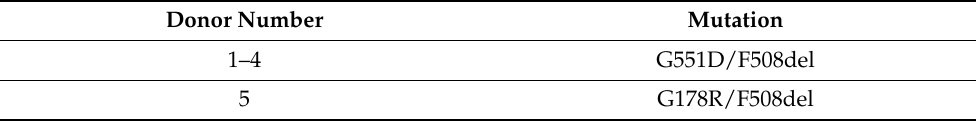
Table 2. CFTR genotypes of individuals who are heterozygous for Class III